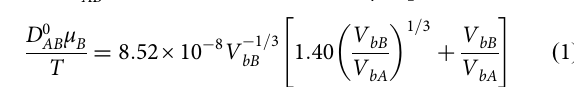
molecules, D 0 (cm 2 s − 1 ), is determined by Eq. (1): AB